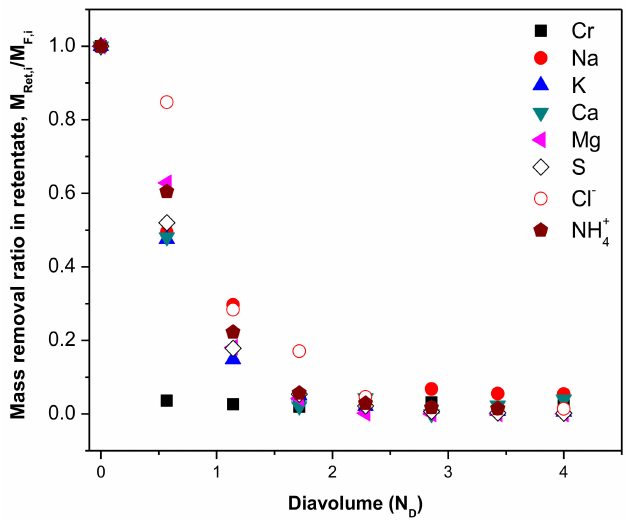
Figure 8. Mass ratio of each compound in the retentate solution during diafiltration with a cs-PES MF022 membrane at 20 bar. Mass ratios were calculated in reference to the total mass of the same compound, M F,i , in the SW30 concentrate of the real tannery effluent before diafiltration (diafiltration feed solution).